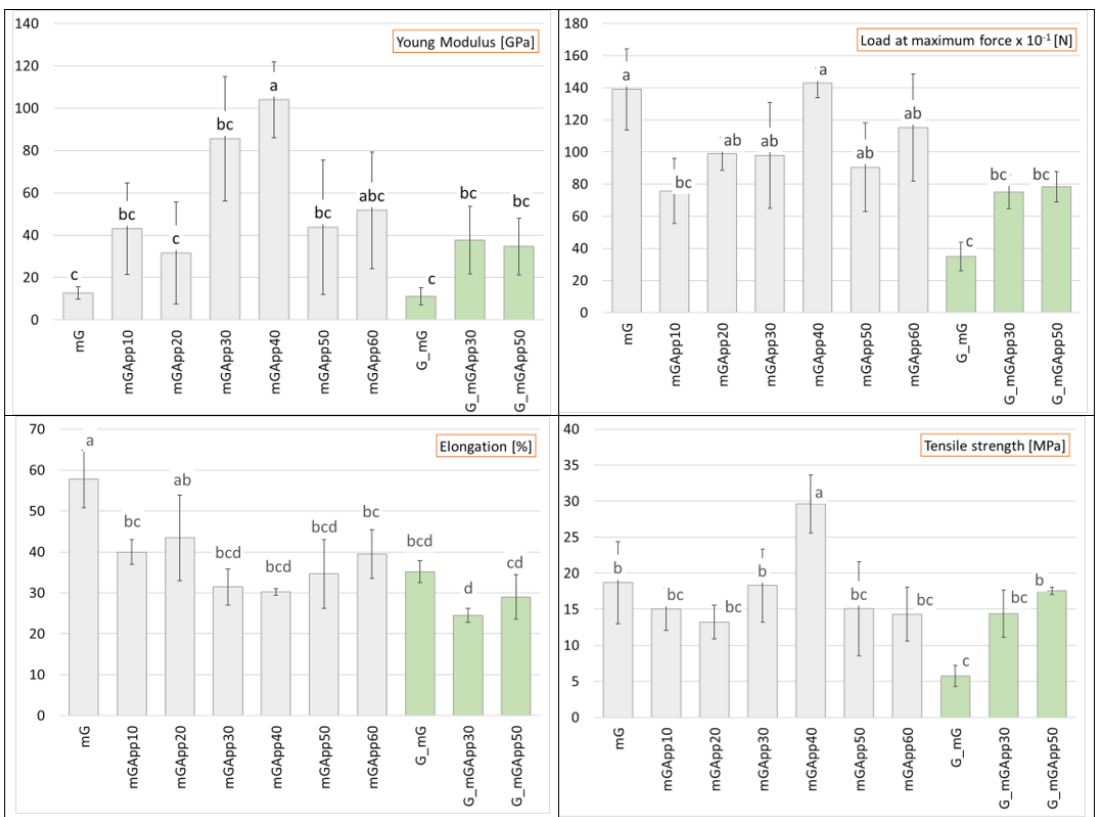
Figure 4. Mechanical strength of the materials: bacterial cellulose modified with glycerol (mG and G_mG); bacterial cellulose pre-treated and modified with glycerol and by entrapping apple powder (mGApp10; mGApp20; mGApp30; mGApp40; mGApp50; mGApp60; G_mGApp30; and G_mGApp50). Bacterial cellulose produced in media without (presented in grey) or with apple powder (presented in green). Different letters represent significant differences.